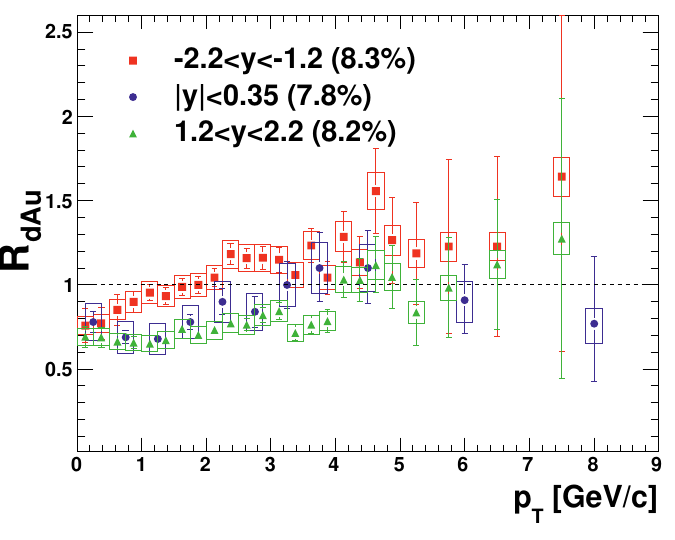
Figure 3. J / / psi nuclear modification factor R dAu as a function of p T for 0-100% centrality integrated d + Au collisions at forward, mid and backward rapidity measured by the PHENIX experiment. Taken from Ref.